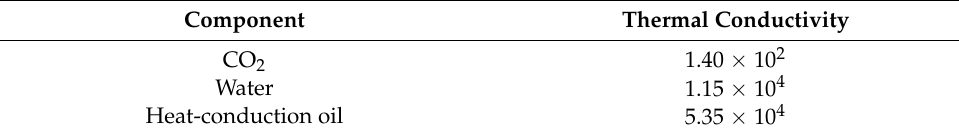
Table 2. The key parameters of the laboratory-size radial model.